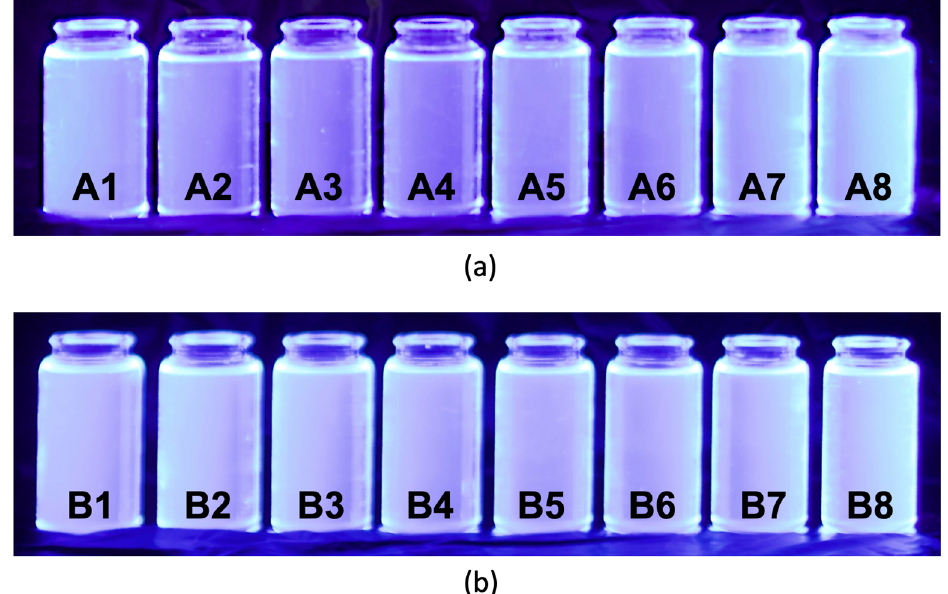
Figure 1. Scintillation light emitted by the LS samples upon UV excitation: ( a ) Eight samples with different PPO concentrations. Left to right: Samples A1 to A8; ( b ) Eight samples with different concentrations of bis-MSB. The PPO concentration is kept constant at 3 g/L. Left to right: Samples B1 to B8.